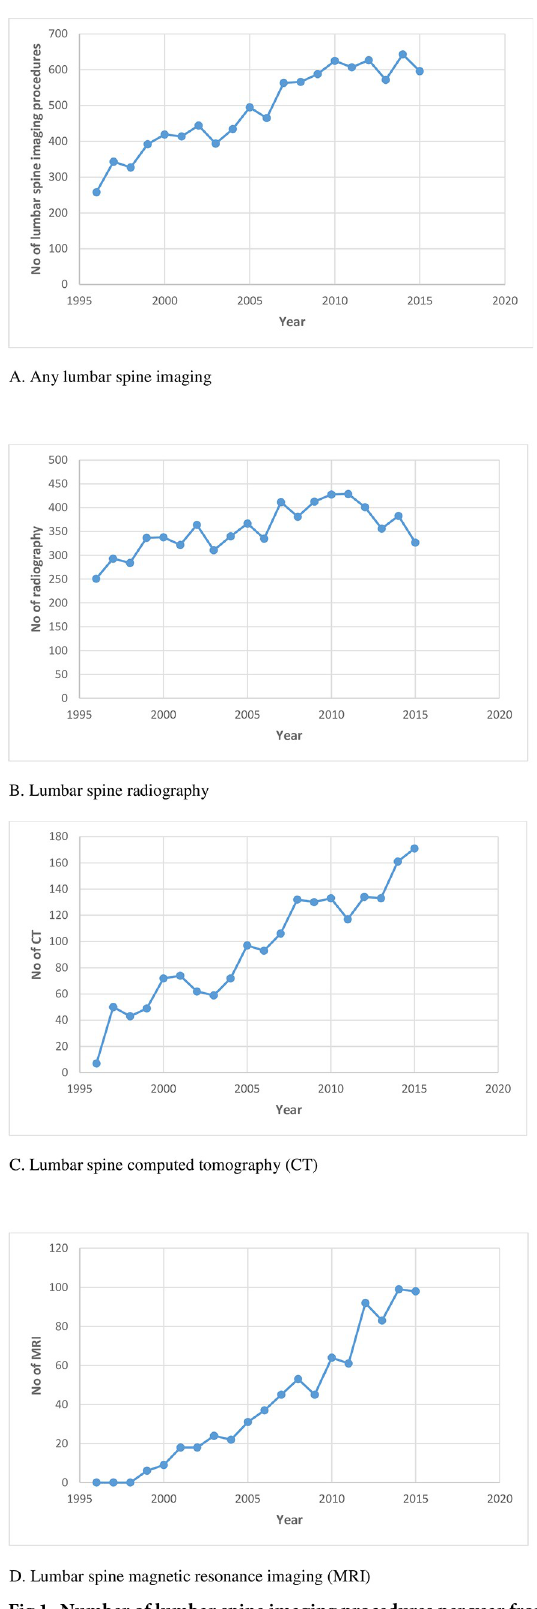
Fig 1. Number of lumbar spine imaging procedures per year from 1996 to 2015. https://doi.org/10.1371/journal.pone.0243282.g001 PLOS ONE | https://doi.org/10.1371/journal.pone.0243282 December3,